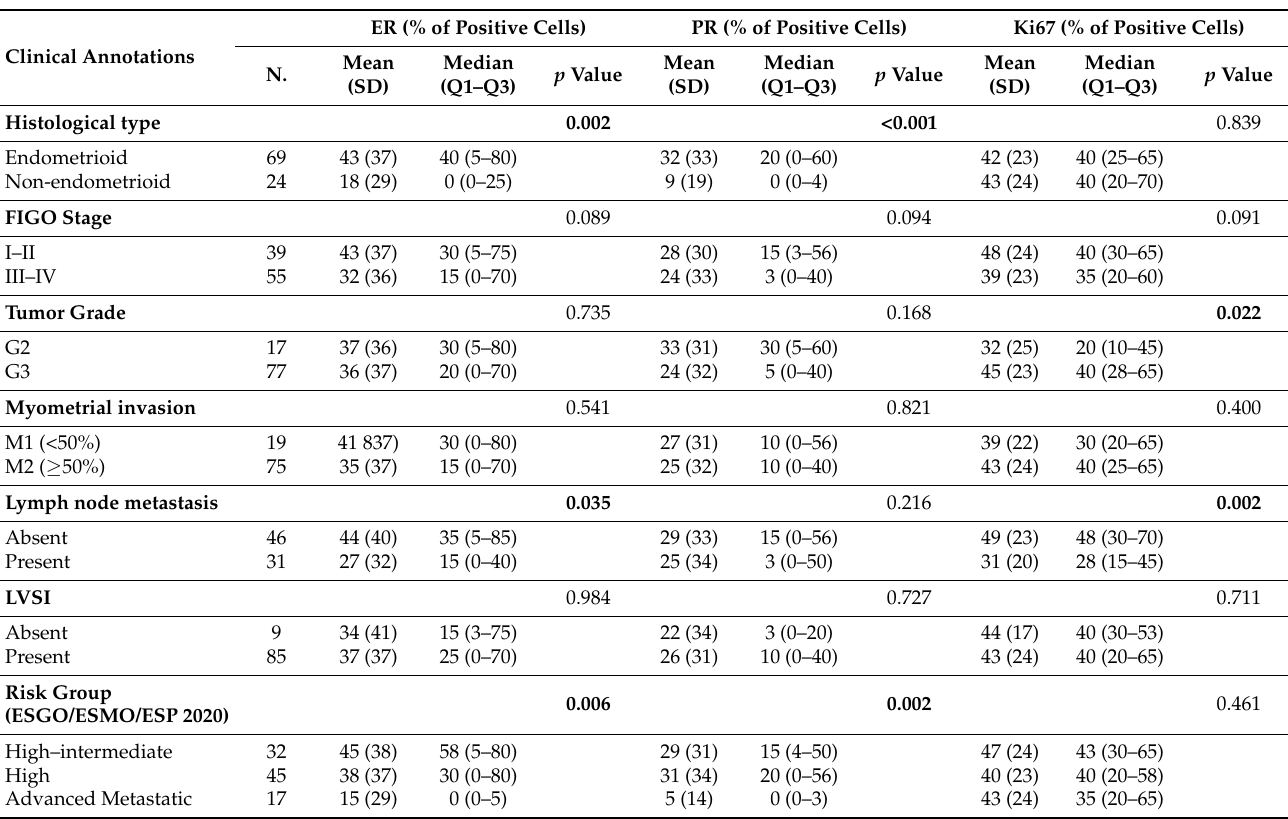
Table A3. Correlation between estrogen receptor (ER), progesterone receptor (PR), and Ki67